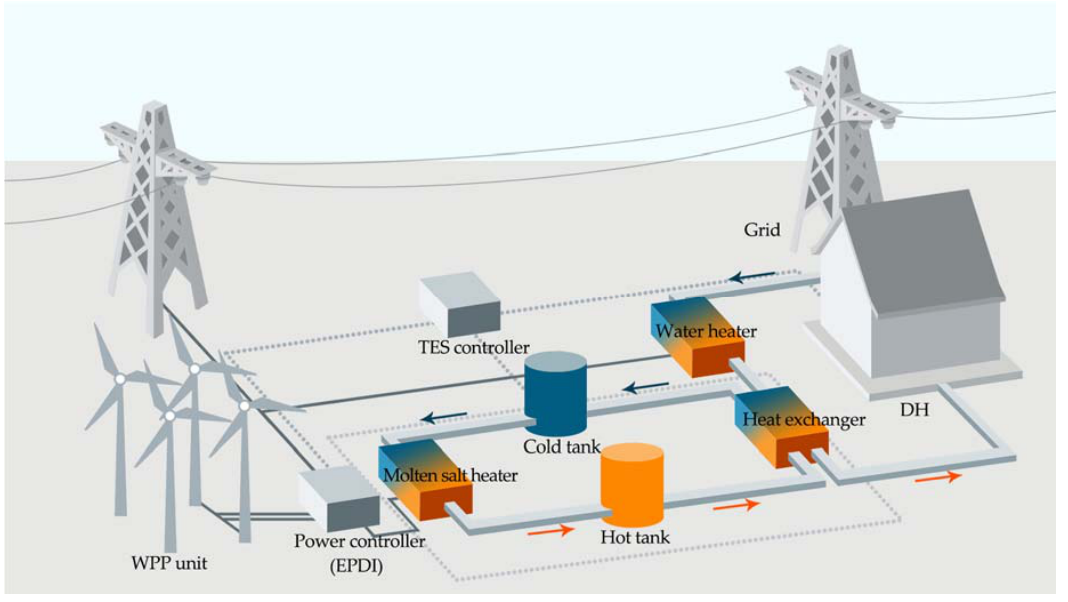
Figure 1. Structure of the two ‐ tank wind ‐ thermal energy storage (WTES) system.